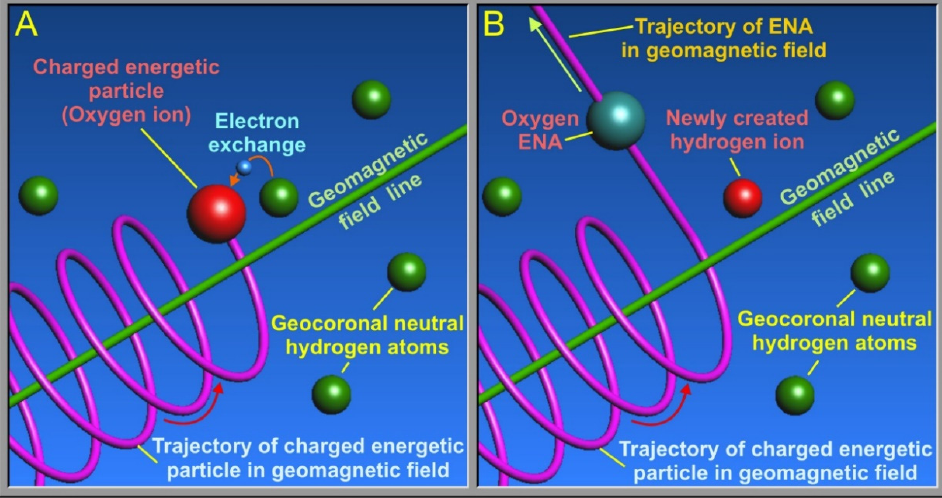
Figure 2. Scheme depicting the charge-exchange process [49]. An electron is transferred from an hydrogen atom to an oxygen energetic ion on collision ( A ), and the oxygen energetic ion changes into an ENA and flies away keeping velocity unchanged ( B